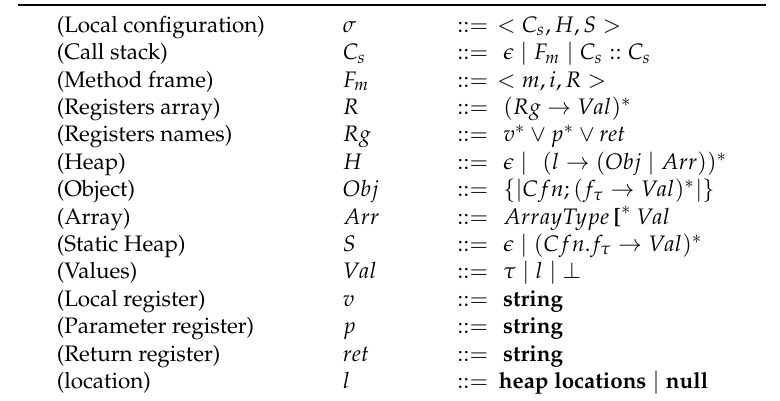
Table 3. Semantic domains.